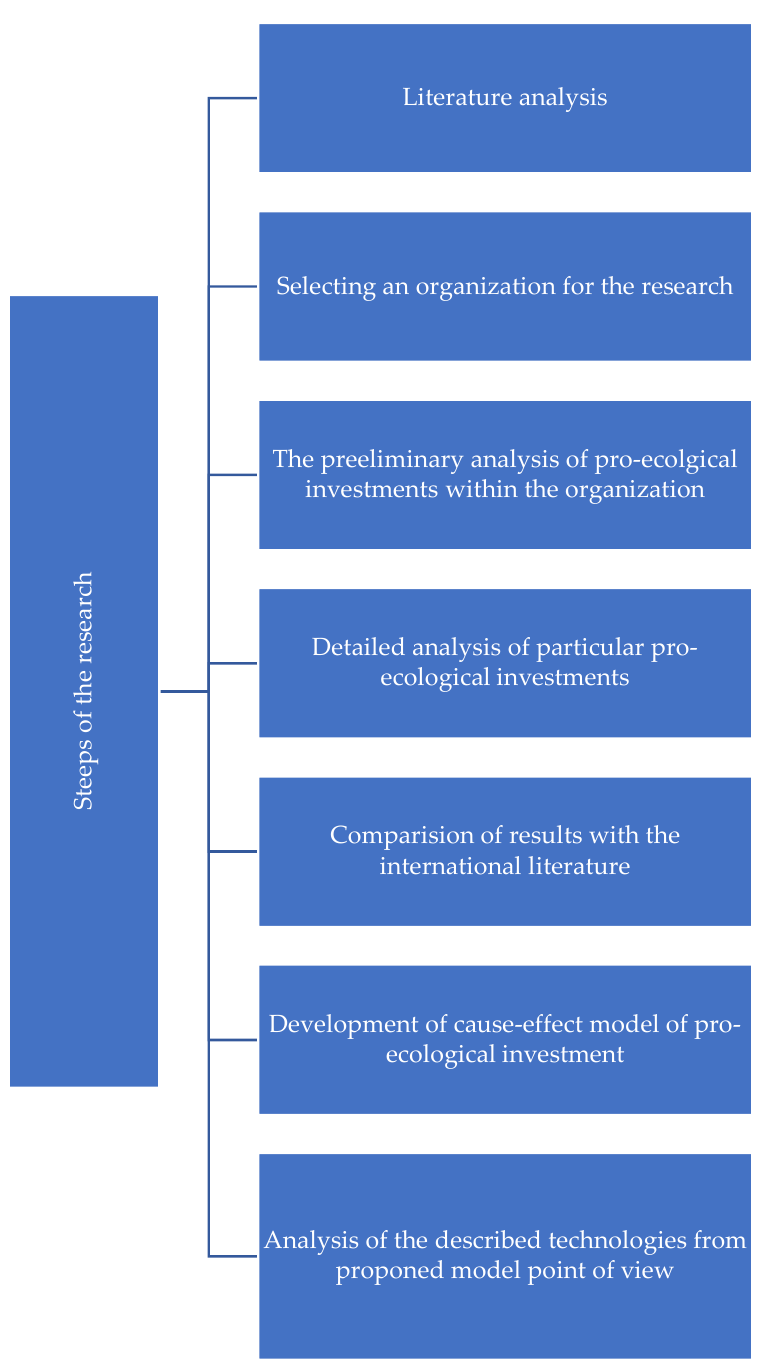
Figure 1. The steps of the conducted research.